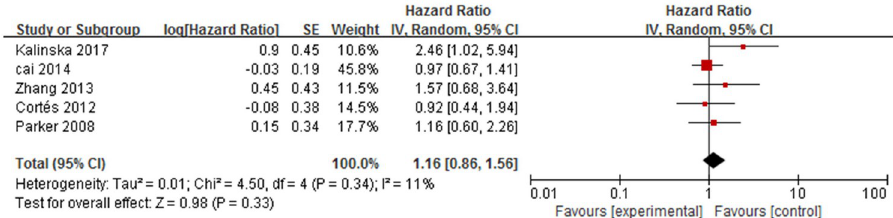
Fig 14. Forest plot of the association between hypertension and bullous pemphigoid